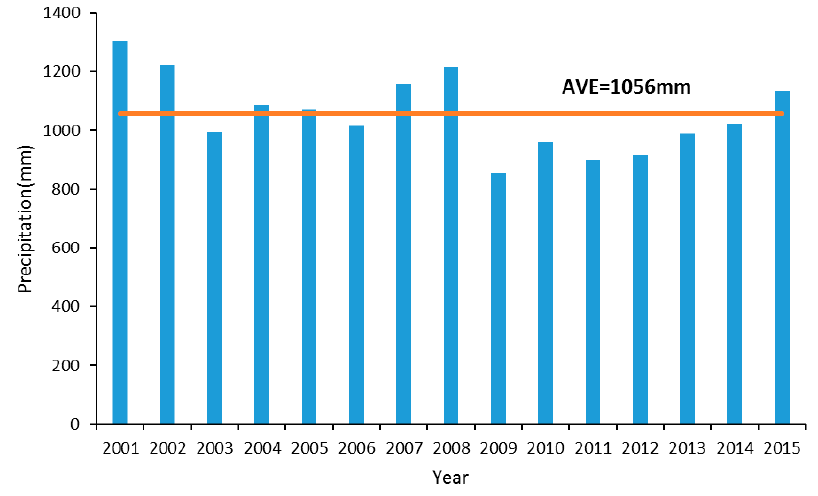
Figure 3. Variation of annual precipitation from 2001 to 2015 over the Red River Basin.